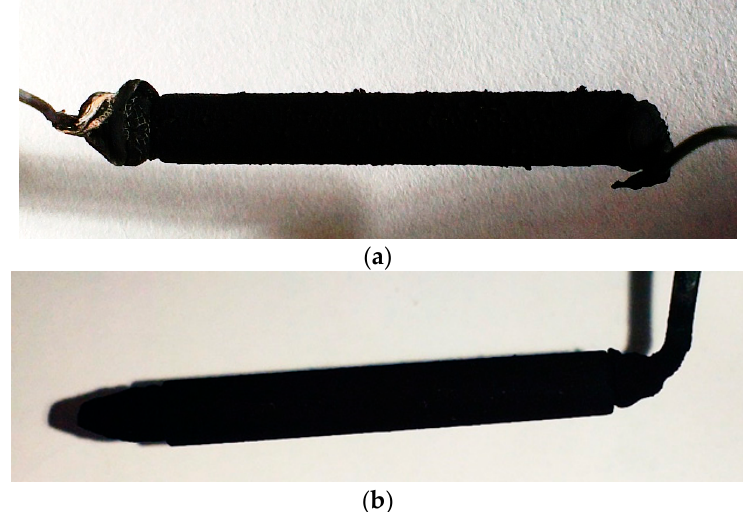
Figure 13. Coating of the catalytic layer: ( a ) the catalytic layer coated manually; ( b ) the catalytic layer coated by self-made device.